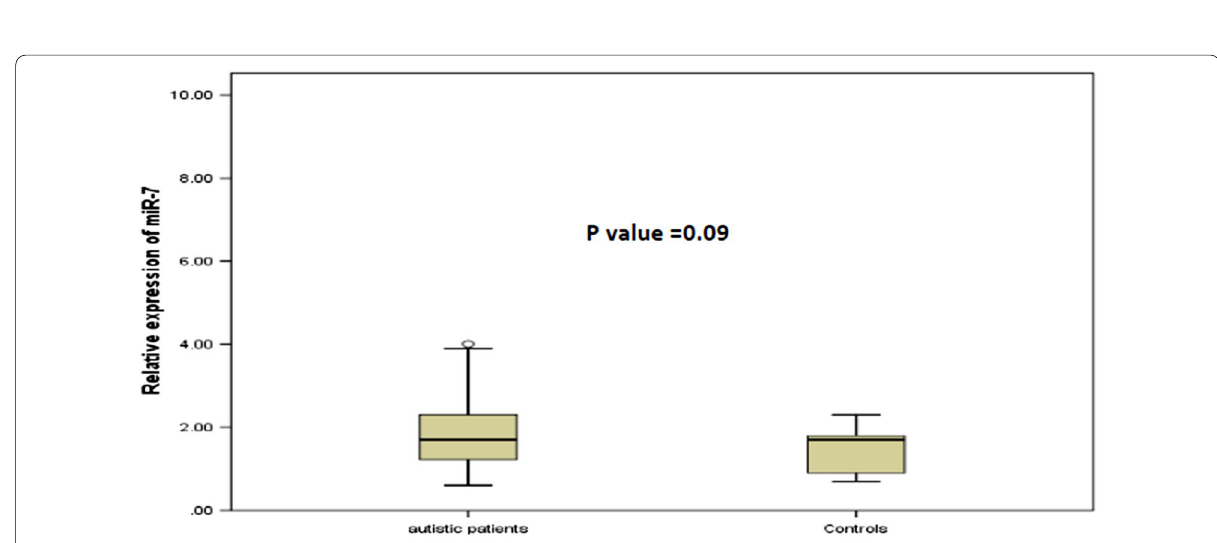
Fig. 3 MiRNA‑7 expression among the studied groups